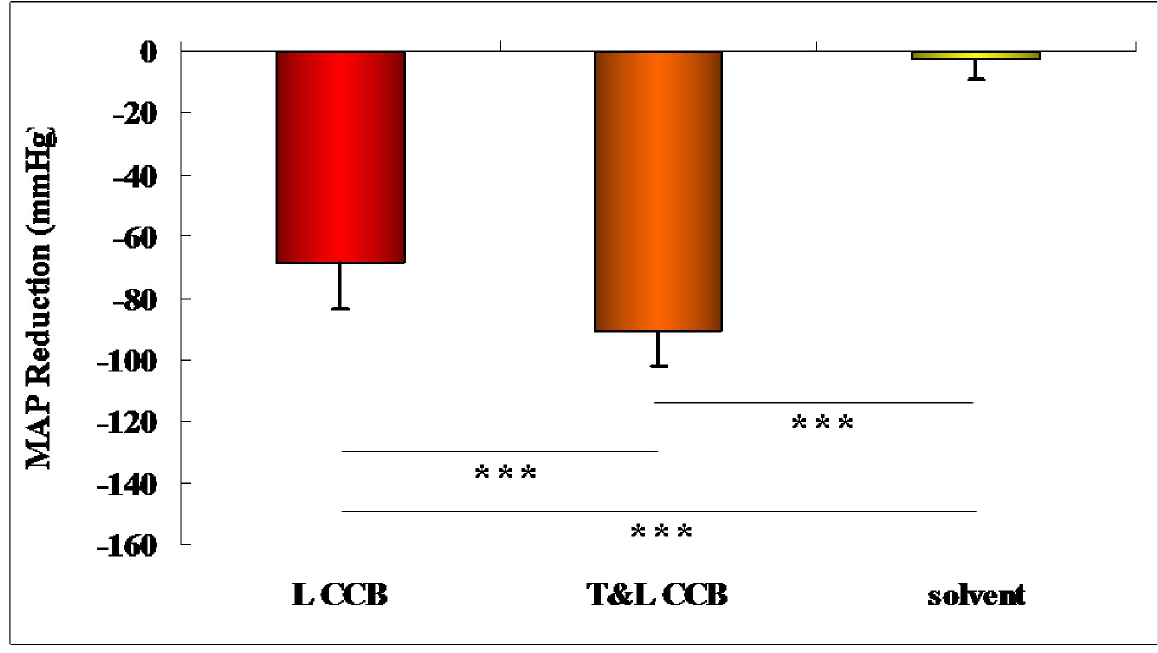
Fig 2. ULE map after drug